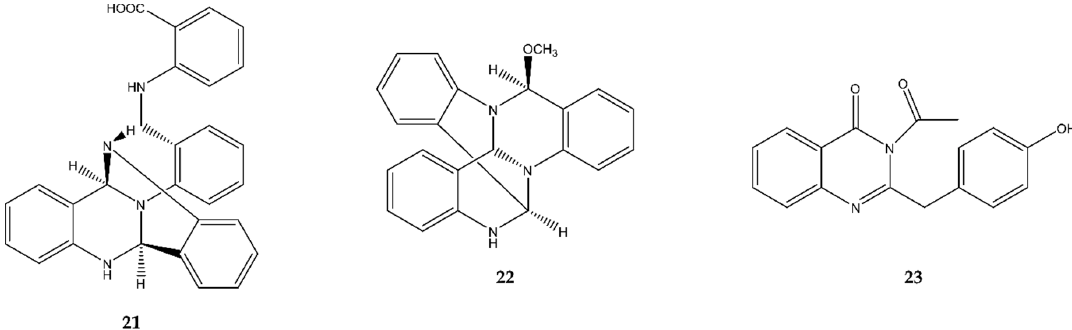
Figure 5. The quinazoline antimicrobial alkaloids oxysporizoline ( 21 ), thielaviazoline ( 22 ), and 2-(4- hydroxybenzyl)-4-(3-acetyl)quinazolin-one ( 23